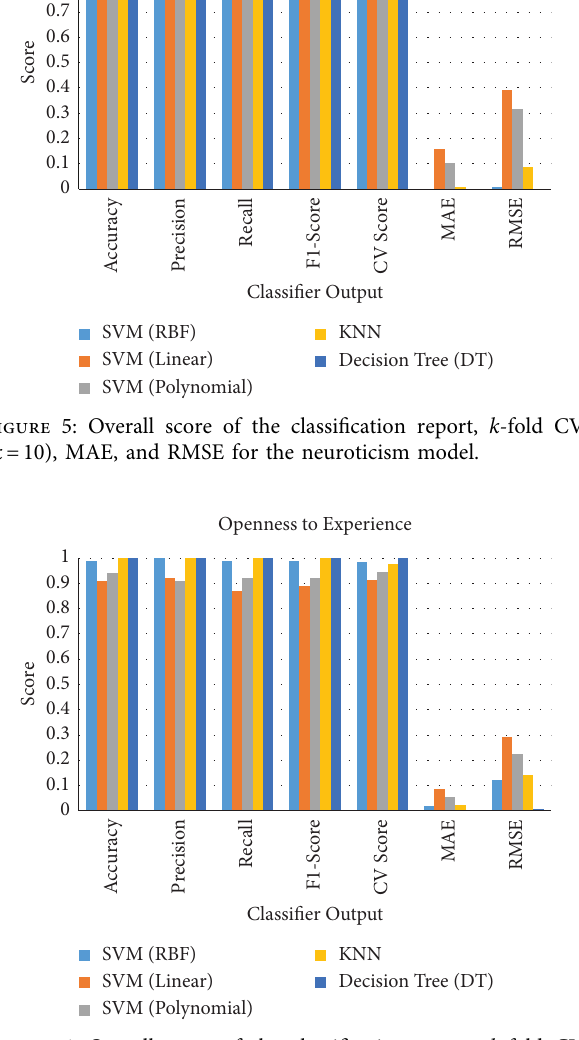
Figure 8: Overall score of the classifcation report, k -fold CV ( k � 10), MAE, and RMSE for the agreeableness